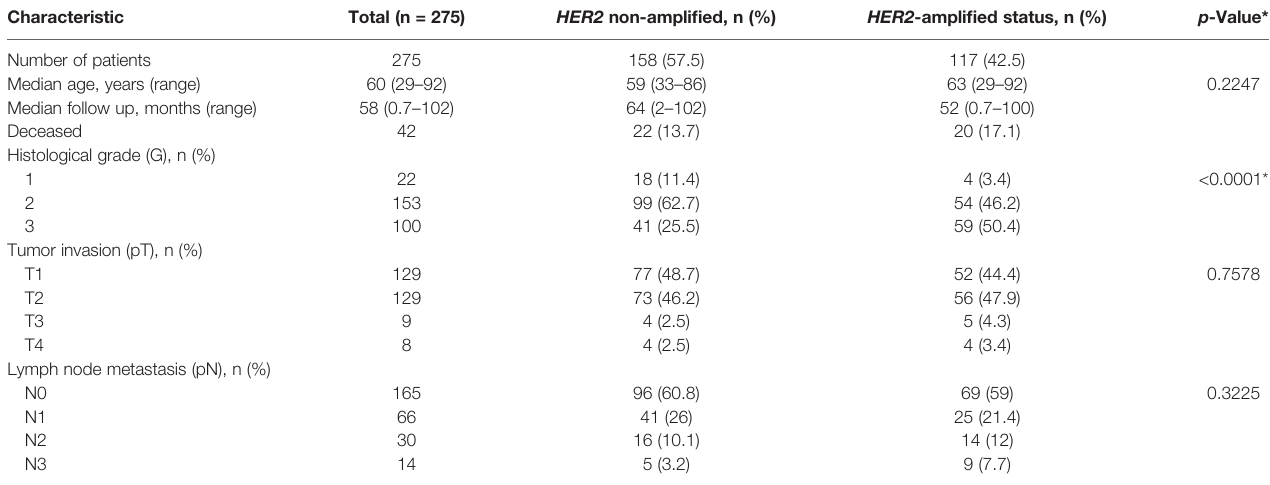
TABLE 1 | Patient and tumor characteristics according to HER2